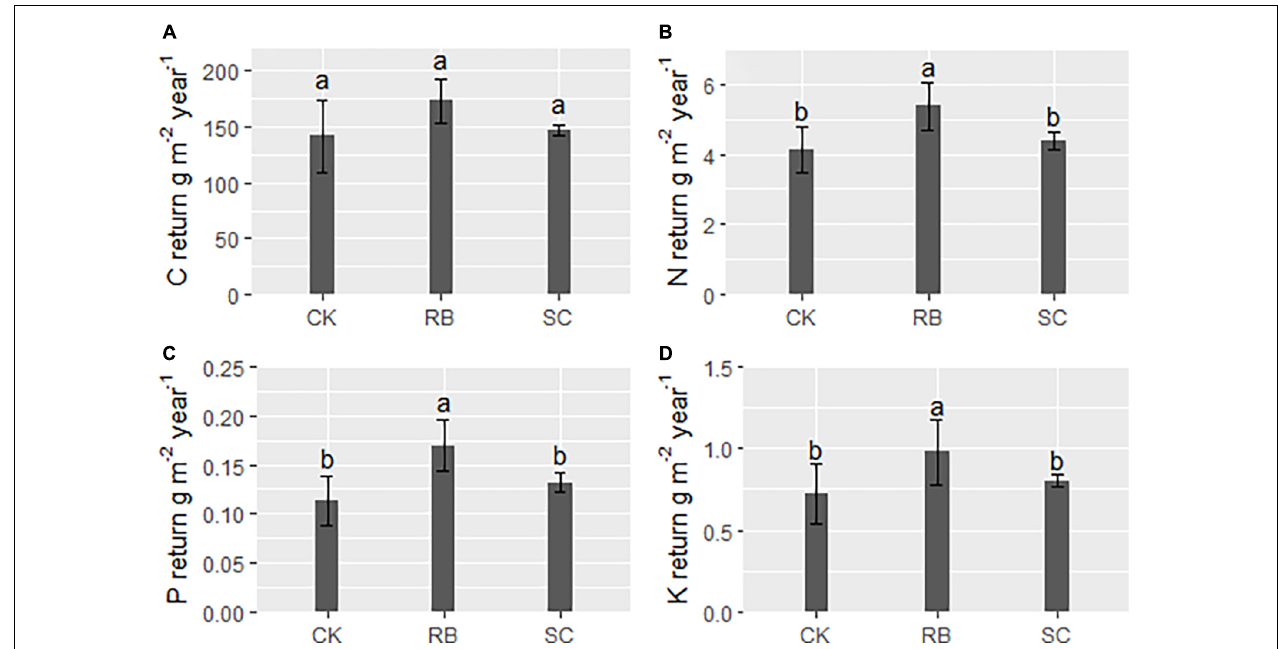
FIGURE 2 | Return of elements ( A , carbon; B , nitrogen; C , phosphorus; and D , Potassium) via litter to forest soil in strip clearcut (SC), reserve belt (RB), and unharvested (CK) plots within a year. Different lowercase letters indicate a significant difference in element return between the three type plots (ANOVA and LSD test, P < 0.05). Error bars indicate standard deviation ( n =